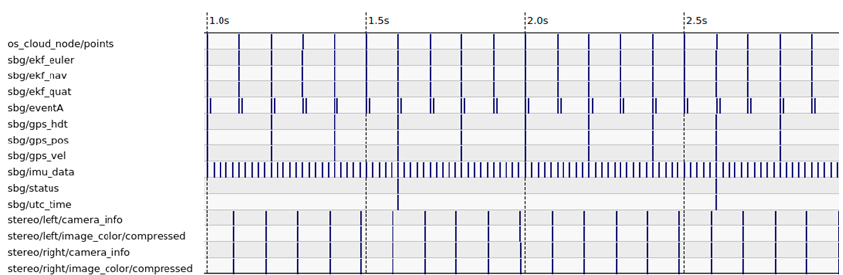
Figure 5. Timeline of data acquisition from the perception and localization platform’s sensors.